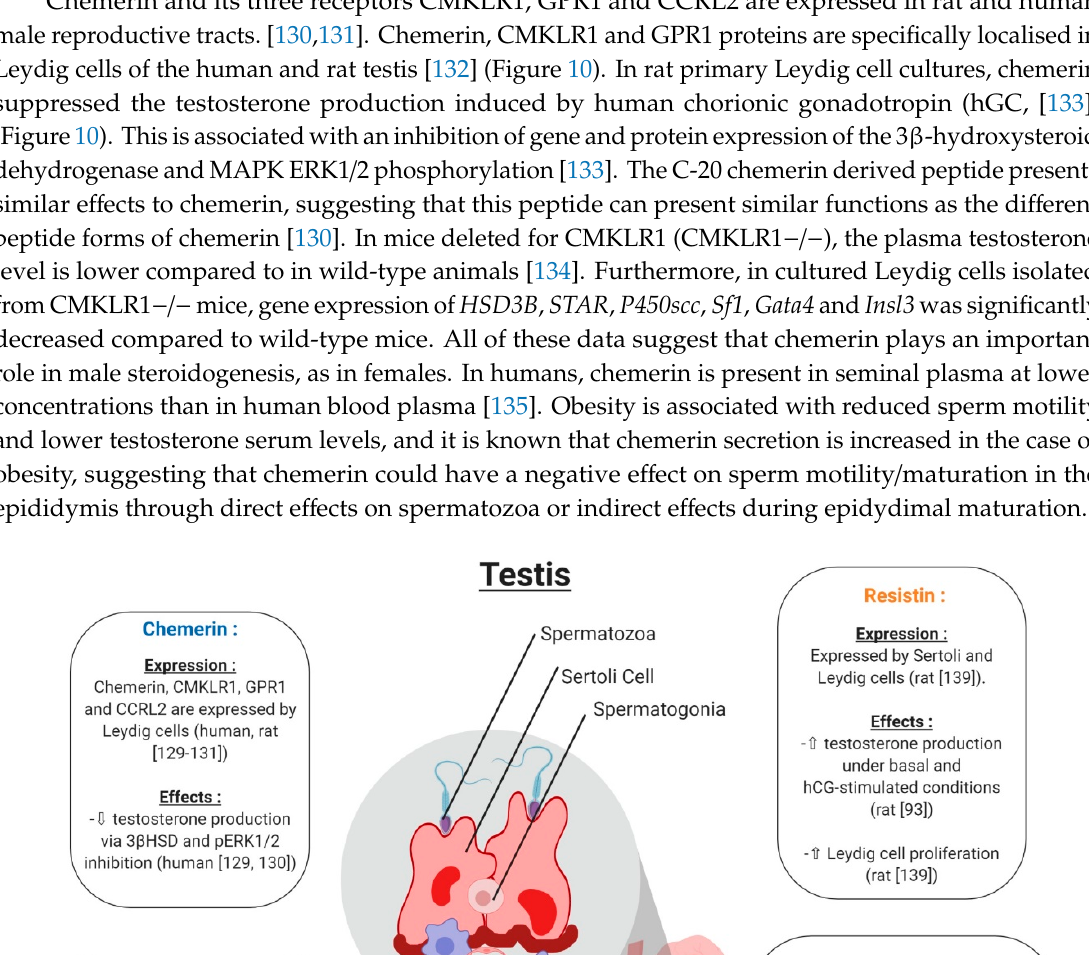
Figure 7. Expression and effects on gonadotropic cells of chemerin, visfatin, resistin and apelin in pituitary. ⇧ Increase/stimulation. ⇩ Decrease/inhibition. ND: not determined.